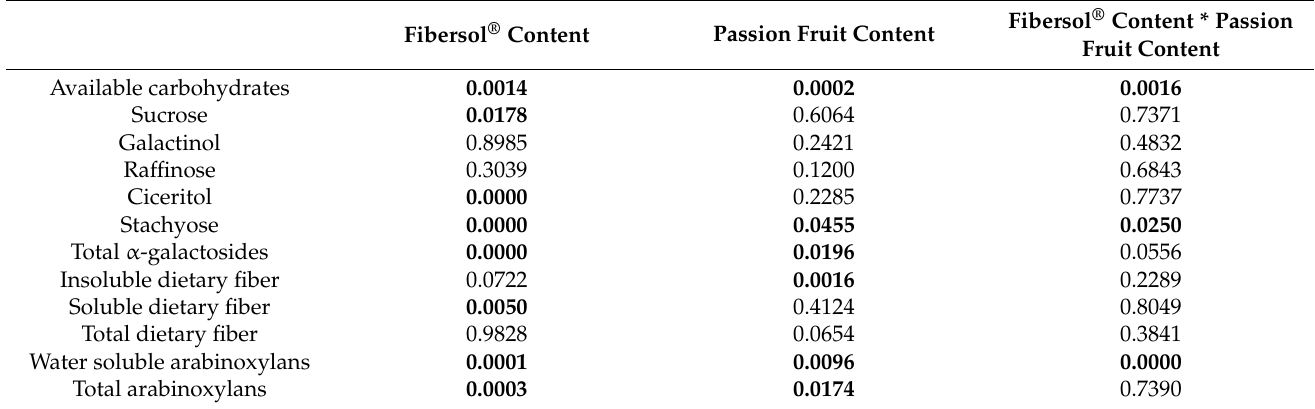
Table 3. Summary p-values of ANOVA main effects and double interactions between Fibersol ® content and passion fruit content on carbohydrate composition of fortified rice–chickpea flours.